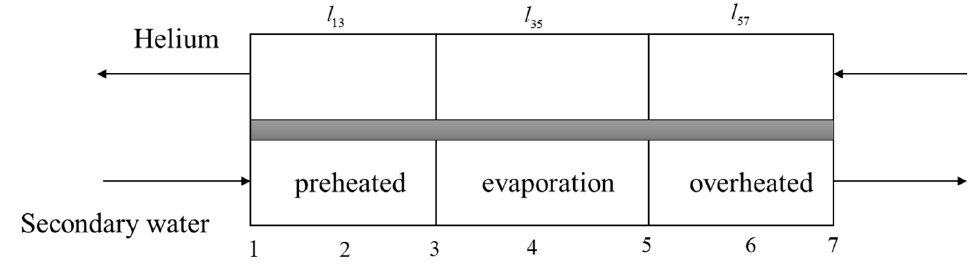
Figure 2. Outline of steam generator model [14].